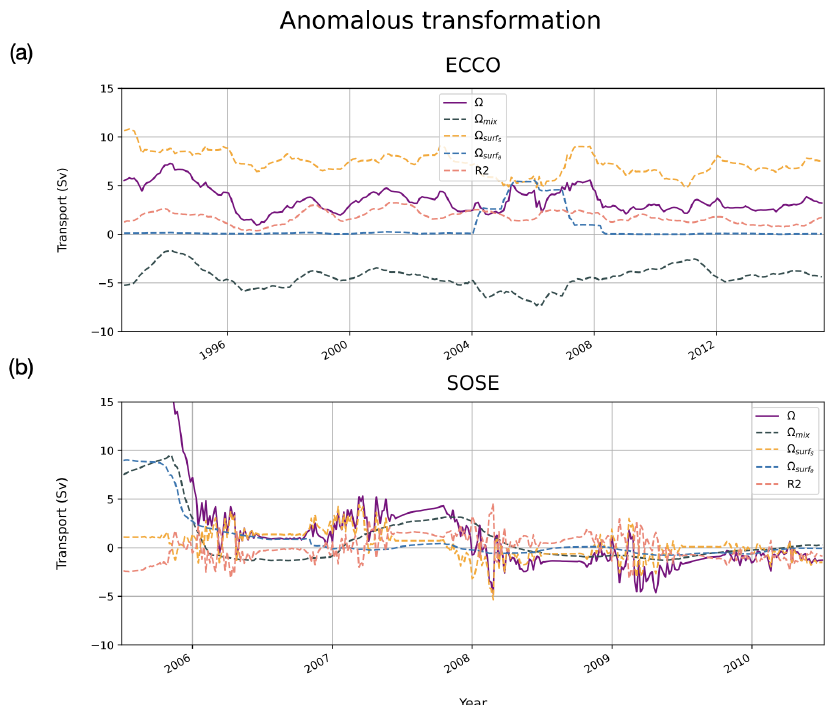
Figure 11. Anomalous transformation term, (cid:127) (solid purple line), broken down into its sources of transformation: surface salt flux (orange dashed line), surface heat flux (blue dashed line) and mixing (slate-grey dashed line). R 2 is the pink dashed line.